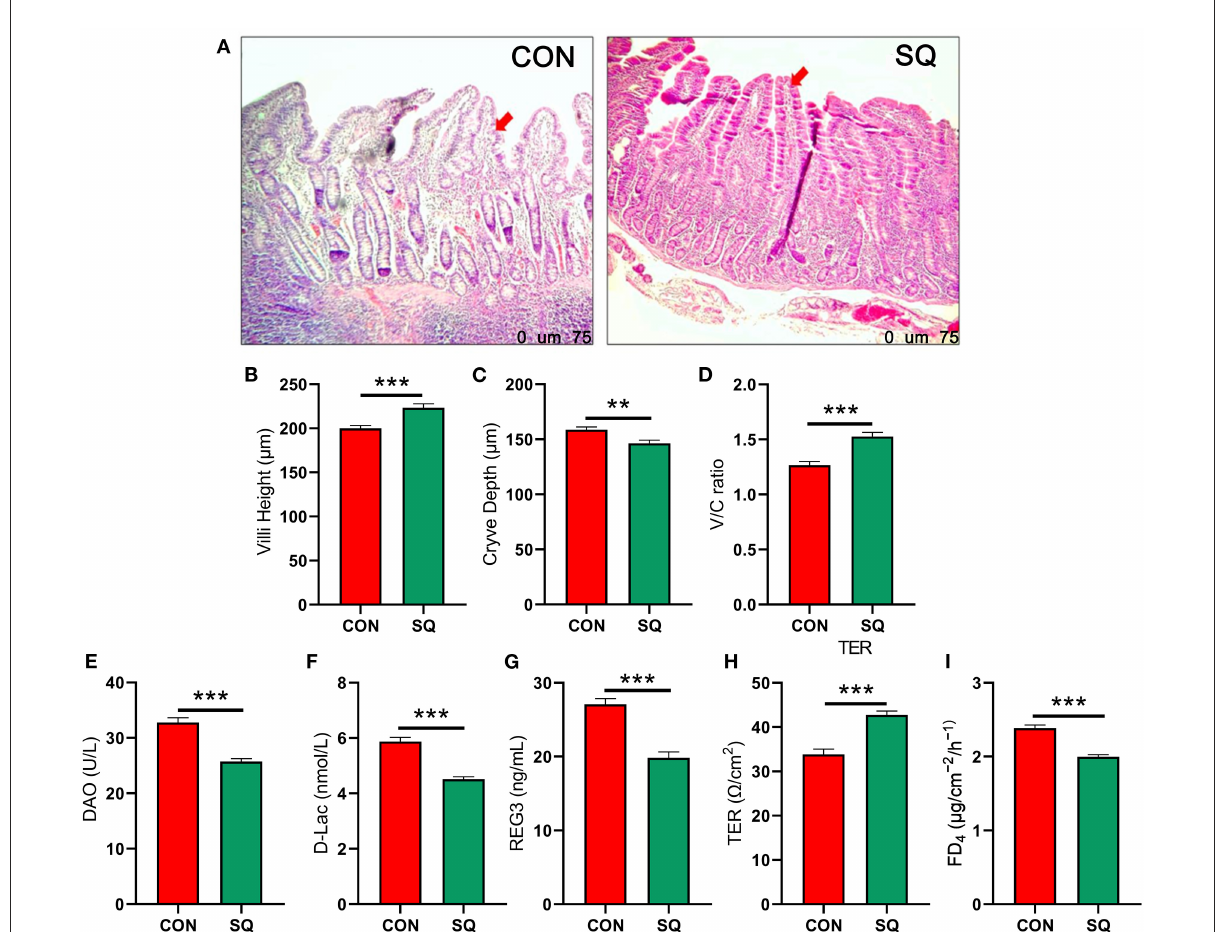
FIGURE3 SQ improves intestinal permeability in early-weaned piglets. (A) H&E-stained sections of jejunum tissues between two groups under 40x microscope; (B) Jejunal villus height. Y-axis = length, X-axis = the treatment groups. *** P < 0.001. (C) Jejunal crypt depth. Y-axis = length, X-axis = the treatment groups. ** P < 0.01. (D) Jejunal V/C ratio. Y-axis = relative abundance, X-axis = the treatment groups. *** P < 0.001. (E–I) Intestinal permeability indicators. Y-axis = amount, X-axis = the treatment groups. *** P <